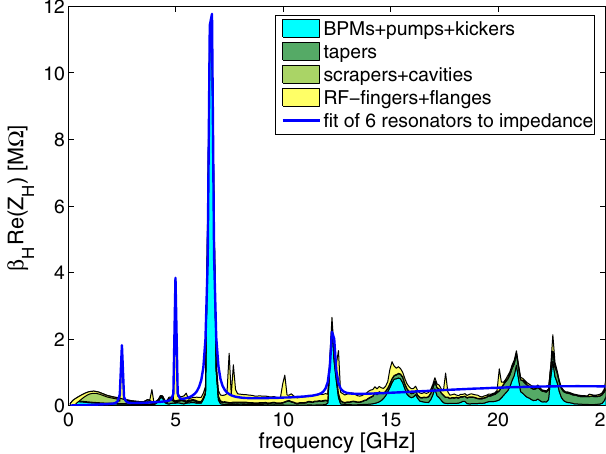
FIG. 13. (Color) Spectrum of the (cid:1) -weighted real part of the horizontal impedance due to geometrical variation.